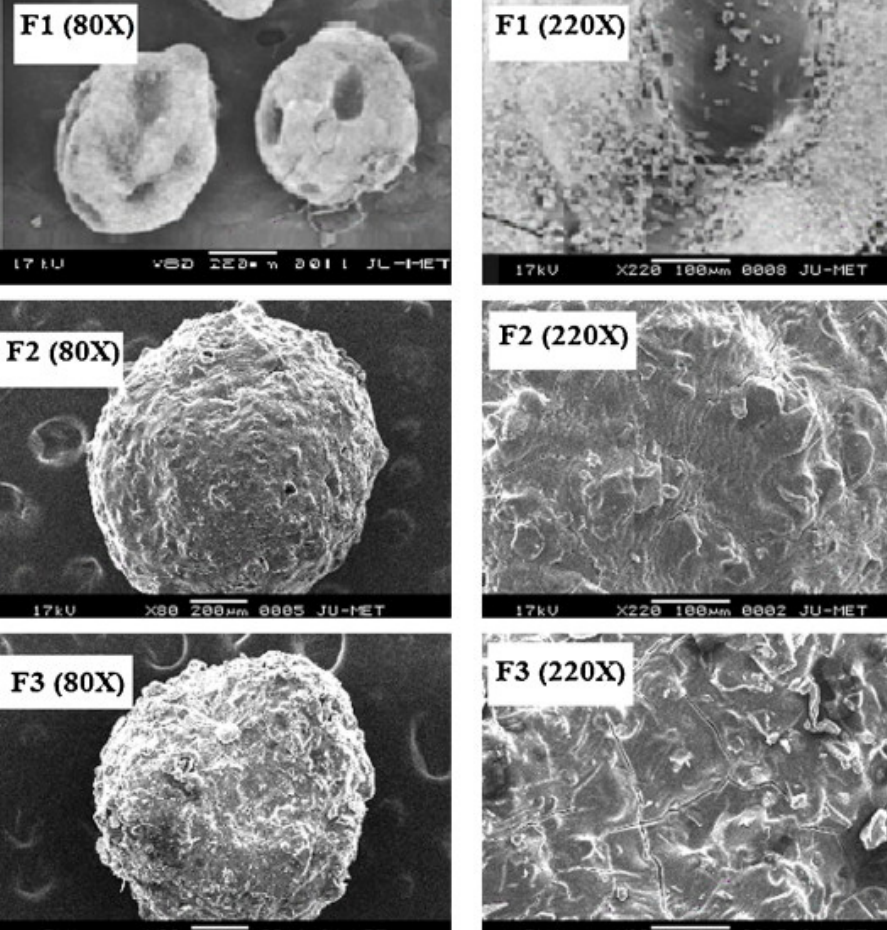
Figure 12. Scanning electron micrographs of resinate-loaded hydrogel beads with 80× and 220× magnification [carboxymethyl xanthan gum hydrogel, prepared with ionic crosslinking (F1), simul- taneous ionic and chemical crosslinking (F2) or sequential ionic and chemical crosslinking (F3)]. Reproduced from [127] with